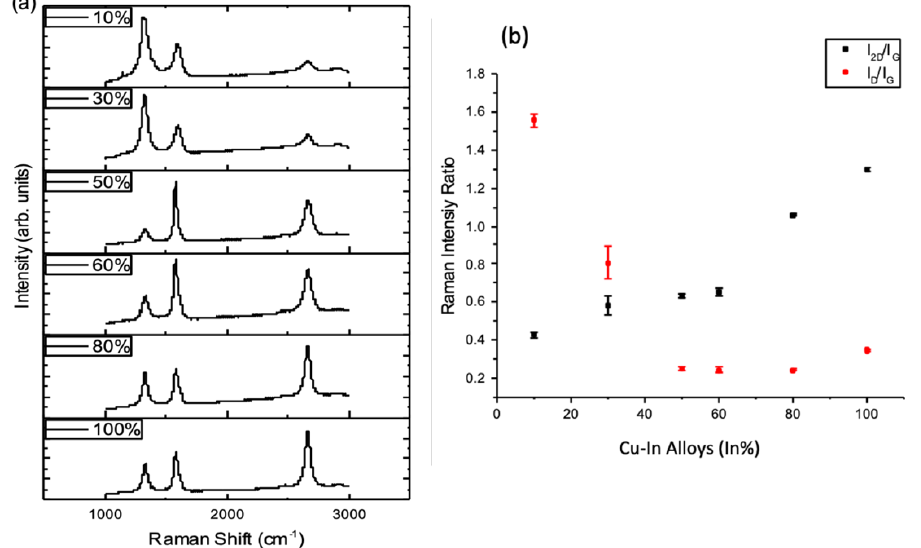
Figure 8. ( a ) Raman spectra from points taken randomly on the surface of the deposited film for the different Cu – In compositions (In%). ( b ) A plot of the average Raman intensity ratios based on >100 points Raman maps, I 2D /I G and I D /I G vs. the wt.% content of In in each Cu – In composition (error bars are smaller than some of the data points) (APCVD, T = 1120 ◦ C, 20 H 2 /500 Ar/5 CH 4 sccm, t = 5 min).